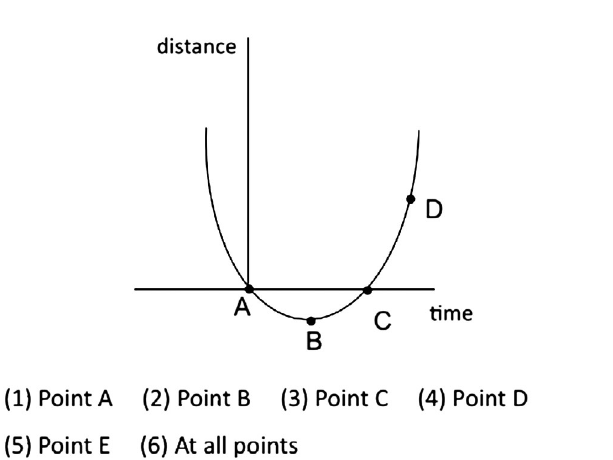
FIG. 7. Problem 3 used in studies 1 and